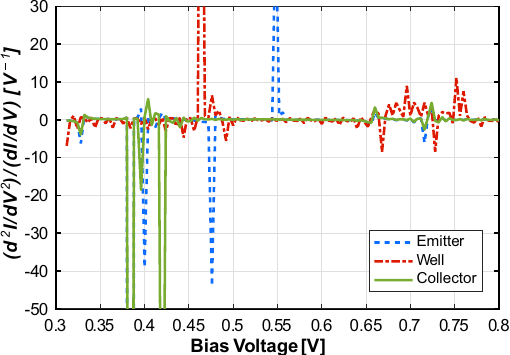
Figure 5. IET spectrum for placement of odorant molecule at different regions of nanowire RTD (bulk phonon mode energy ħ ω = 0.175 eV and vibron energy ħ ω f = 0.09